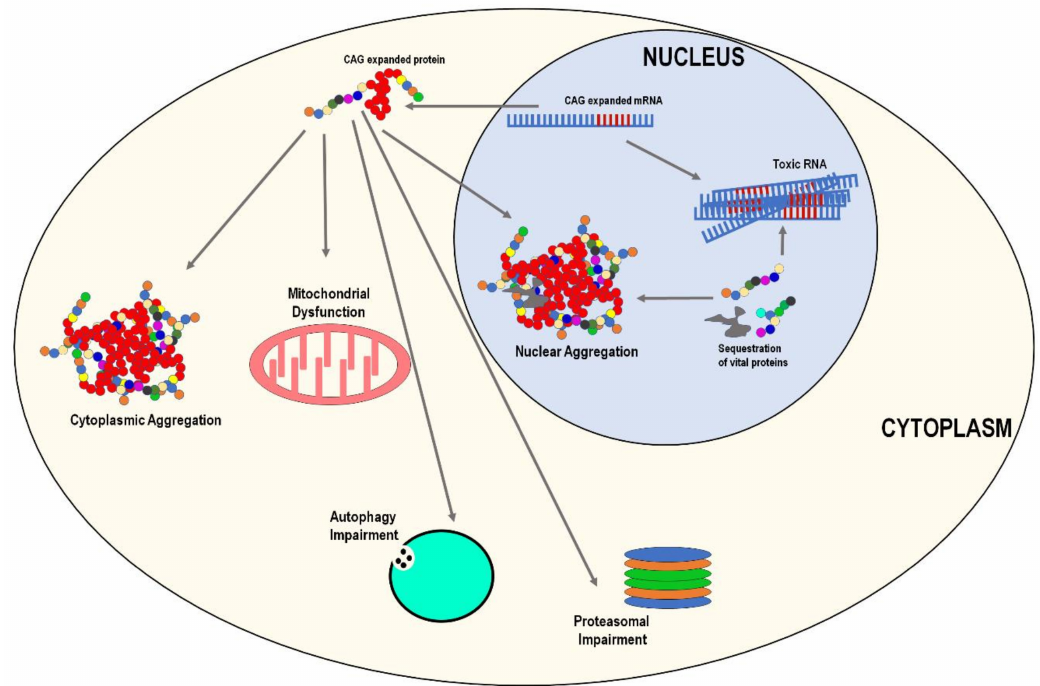
Figure 2. Schematic representation of some of the common cellular pathologies associated with polyglutamine spinocerebel- lar ataxias (SCAs). Polyglutamine (polyQ) expanded mRNA has the ability to form toxic RNA compounds prior to being translated to a polyQ expanded protein. Following translation, polyQ expanded proteins form neuronal cytoplasmic and nuclear inclusions. The expanded polyQ protein causes both proteasomal and autophagy impairment. The polyQ expanded proteins also have the ability to cause mitochondrial dysfunction. PolyQ amino acids are presented as red circles, while CAG nucleotides on the polyQ mRNA as red ‘fingers’ on the mRNA